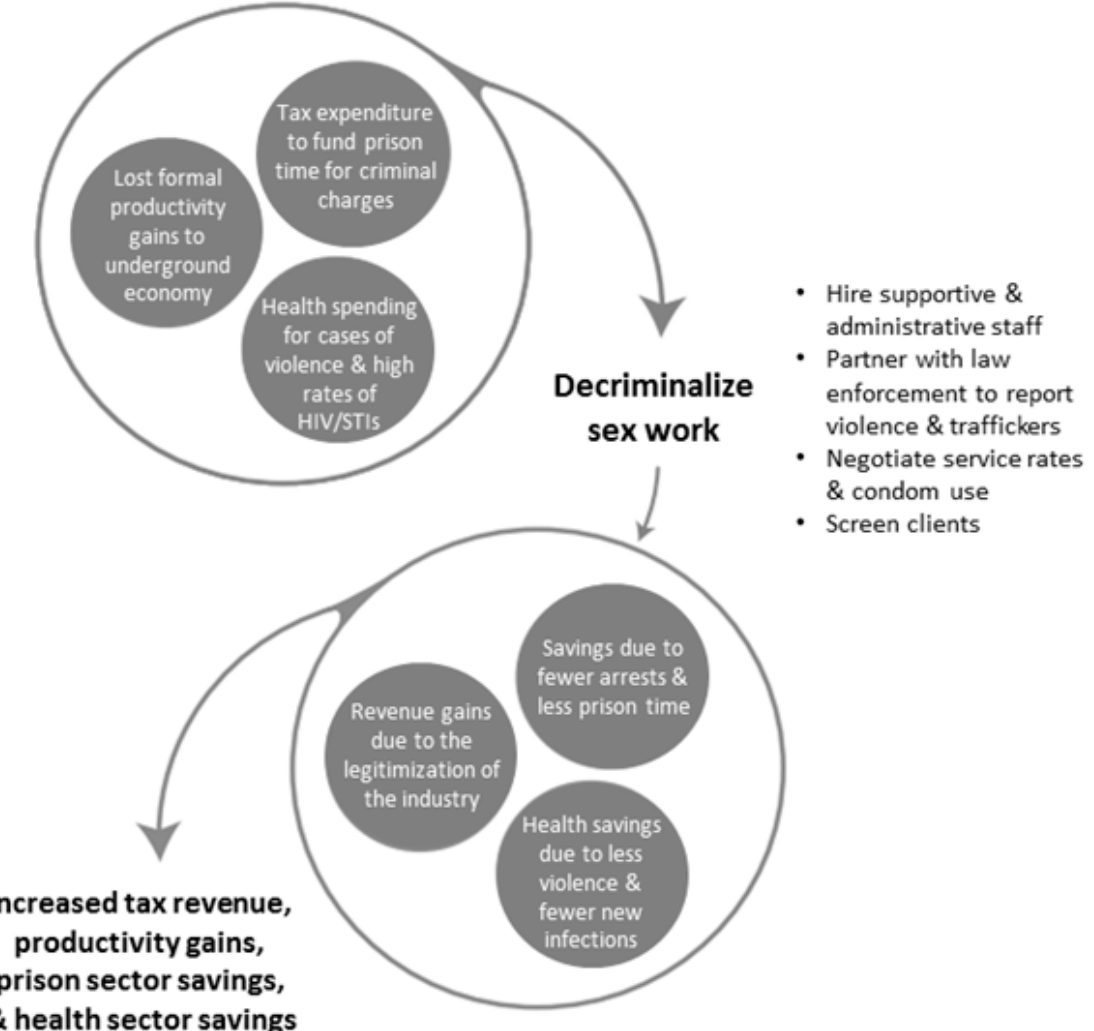
Figure 1. Social and economic consequences of decriminalizing sex work. Authors’ own work based on Segal et al. [13].